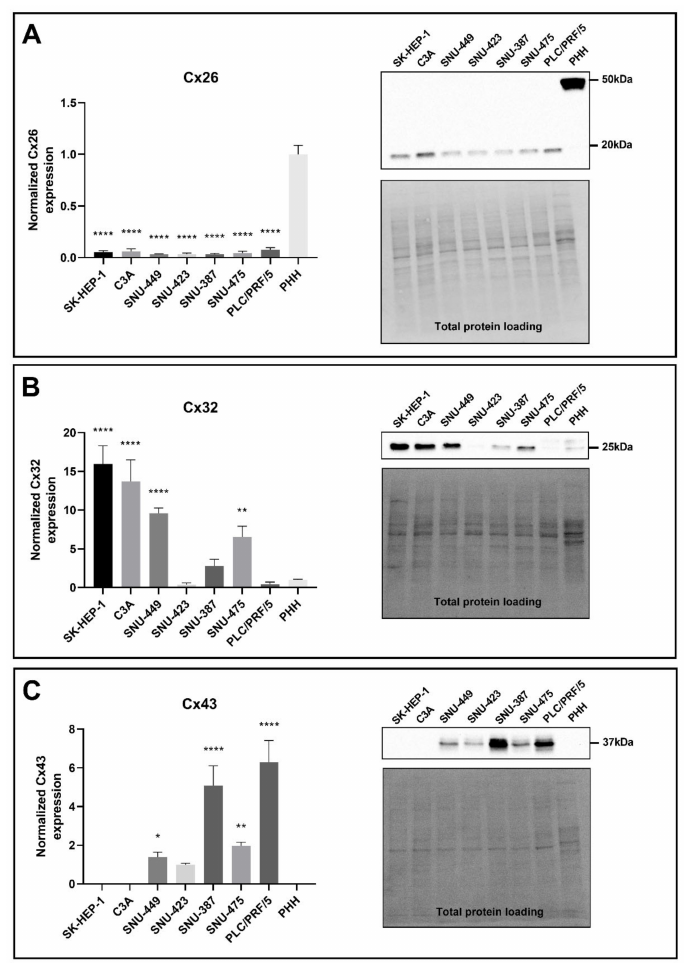
Figure 3. Cx26 ( A ), Cx32 ( B ) and Cx43 ( C ) protein expression in liver cancer cell lines and primary human hepatocytes (PHH). Cancer cell lines ( n = 1, N = 3) were grown to 100% confluence, while PHH were used in suspension for protein extraction. Immunoblotting and visualization were done with the Pierce™ ECL Western Blotting Substrate kit (Thermo Fisher Scientific, Waltham, MA, USA) on a ChemiDoc TM MP imaging system. All signals were divided by their respective total protein loading signal and normalized by the sum of all data points in a replicate [42]. Unlike Cx43, which was not expressed by PHH, Cx26 and Cx32 are expressed relative to their expression in PHH. Data are expressed as mean ± standard deviation with * p ≤ 0.05, ** p ≤ 0.01 and **** p ≤ 0.0001 compared to the PHH